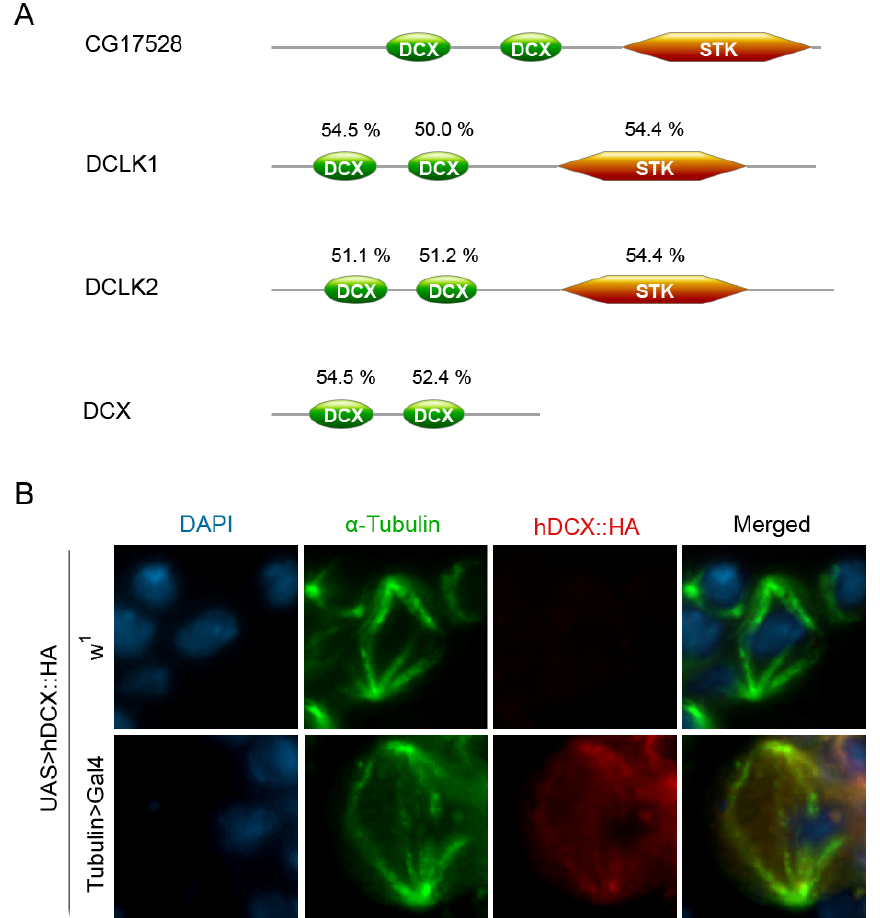
Figure 2. The CG17528 (d-doublecortin) protein. ( A ) Sequence conservation of CG17528 with its human orthologs. Schematic representation of specific functional domains showing identity levels. Pairwise sequence alignment and protein domain analyses were performed using EMBOSS Needle (www.ebi.ac.uk/Tools/psa/emboss_needle/ (accessed on 4 August 2022)) and PROSITE (www.expasy.org/resources/prosite (accessed on 28 July 2022)), respectively. ( B ) Expression and localization of a HA-tagged human DCX fusion protein in larval brain cells of D. melanogaster . Squashes preparation stained with DAPI (blue), anti- α -tubulin (green), and anti-HA (red). After expression with the Tubulin>GAL4 driver, the HA signals were found at both the spindle poles and fibers. The signals were absent in the control flies carrying the HA-tagged human DCX fusion gene, in absence of the